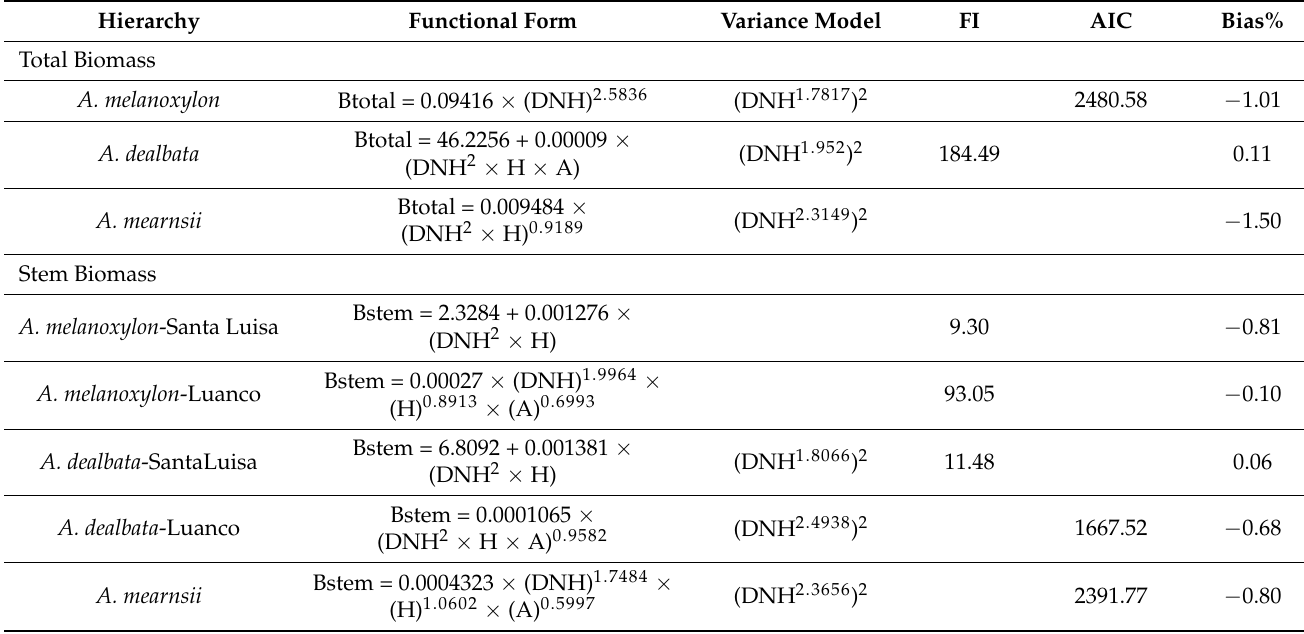
Table 2. Comparison of the total biomass models and biomass of branches, foliage, bark, and stem.